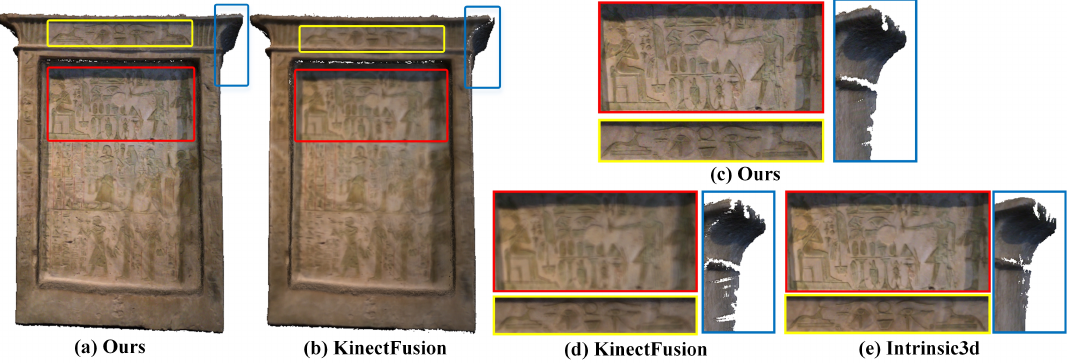
Figure 6. The reconstruction results of the Hieroglyphics dataset. Our results ( a , c ) are better in geometry and texture than the classical weighted average fusion method [6] ( b , d ), and can reach the level of o ffl ine optimization of intrinsic3d reconstruction framework [5] ( e